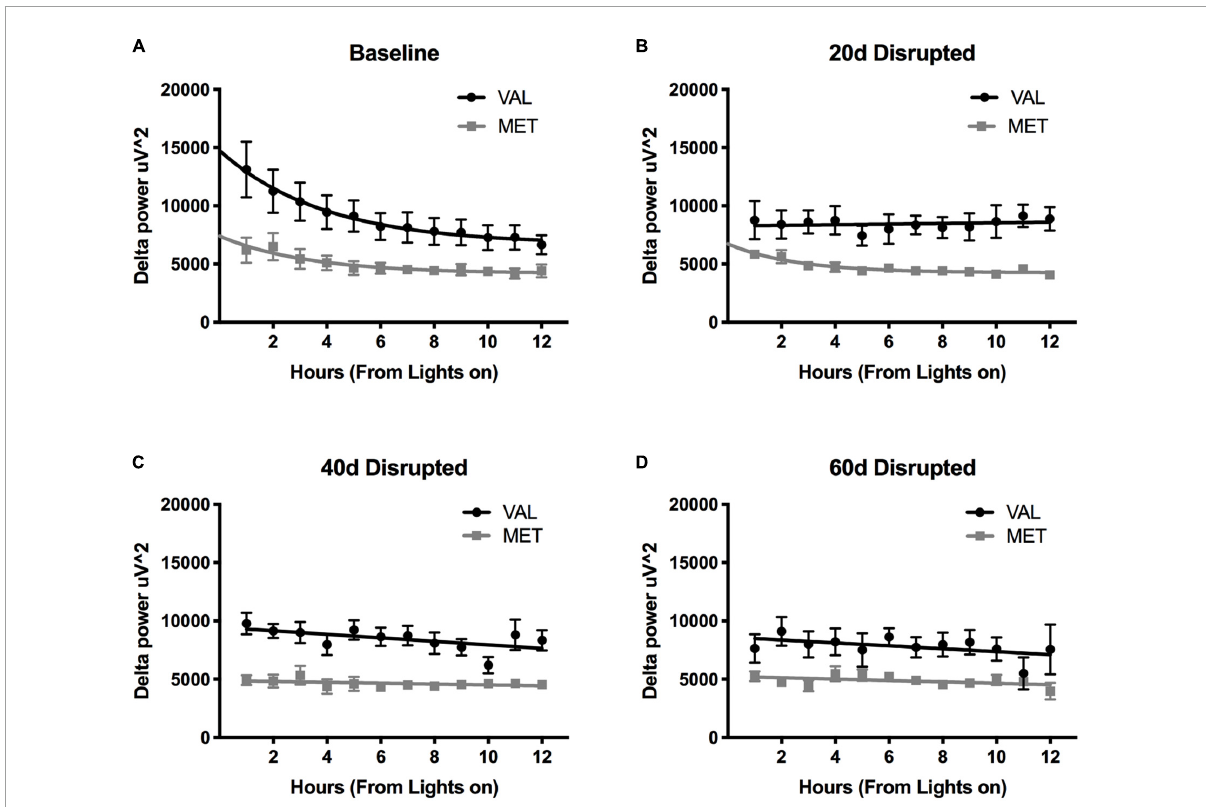
FIGURE3 Length of time in ECD changes delta power differently in Val and Met mice. Graphs depict changes in NREM sleep delta power (0.5–4 Hz) in Val (black lines) and Met (gray lines) starting at light onset for baseline LD12:12 (A) , 20 days (B) , 40 days (C) , and 60 days (D) of LD10:10 ECD. Best fit lines were generated by comparing an exponential decay to a straight line. Light onset NREM delta power from baseline recordings (A) best fit to an exponential decay model, with increased delta power at light onset and dissipates over time. However, after 20 days (B) , 40 days (C) , and 60 days (D) of LD10:10 ECD, delta power from the Val mice best fits a linear model, showing no rise in light onset delta power. After 20 days of LD10:10 ECD, Met mice still fit an exponential decay in light onset delta power, but best fit a liner model after 40 days or 60 days.